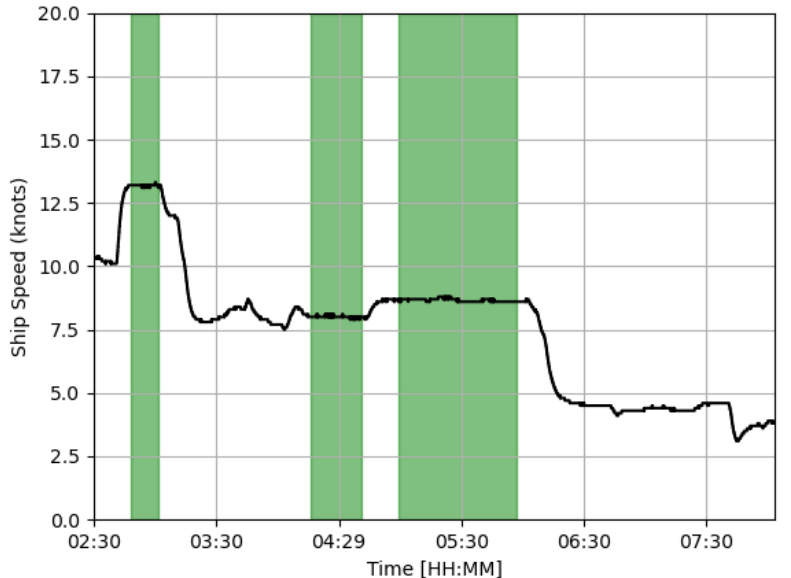
Figure 12. Open-water longitudinal speed of CCGS Henry Larsen; 2 to 6 a.m., 30 October 2021.